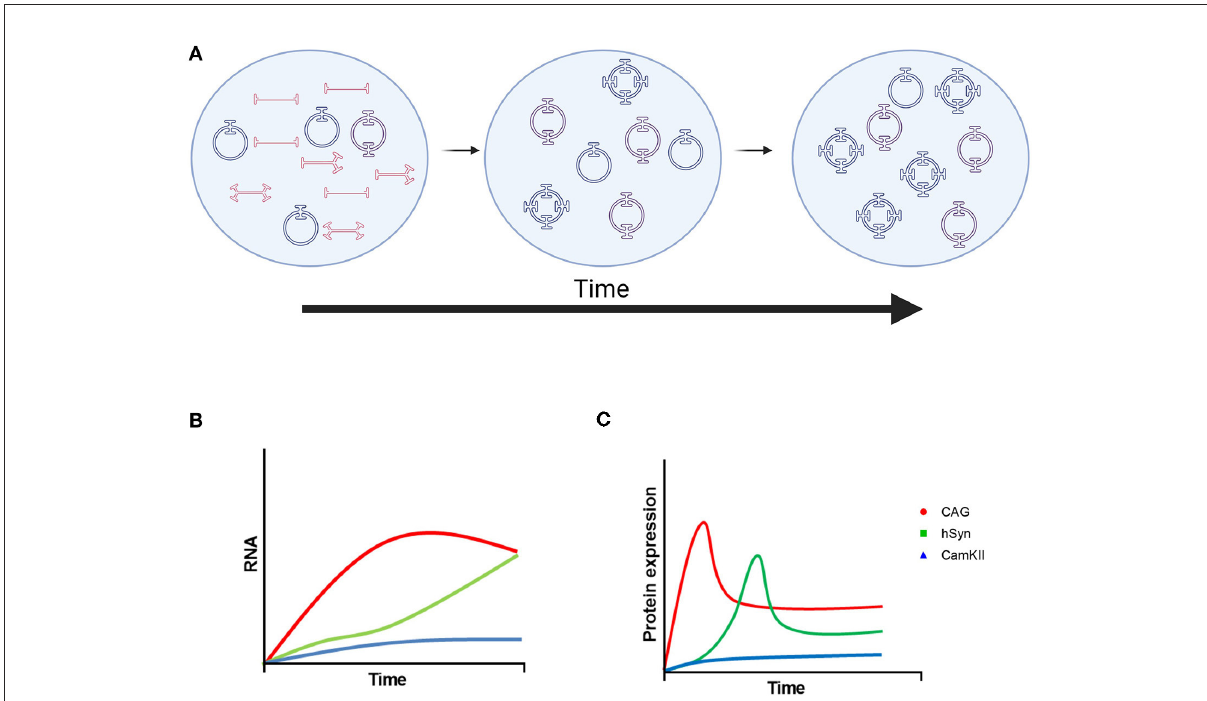
FIGURE5 Model of rAAV9 genome processing and transgene expression. (A) Linear single-stranded rAAV DNA is transported to the nucleus and then converted to linear double-stranded genomes by second-strand synthesis or strand annealing. Linear double-stranded genomes are converted to stable, circular episomes as monomers or concatemers. Over time, the number of AAV genomes per circular episome increases until it becomes stable. The format of AAV DNA contributing to the increase in concatemer size is currently uncharacterized. (B) Proposed mRNA and (C) protein kinetics of transgenes driven by the CAG, hSyn, and CamKII promoters. Created using images from BioRender.com.